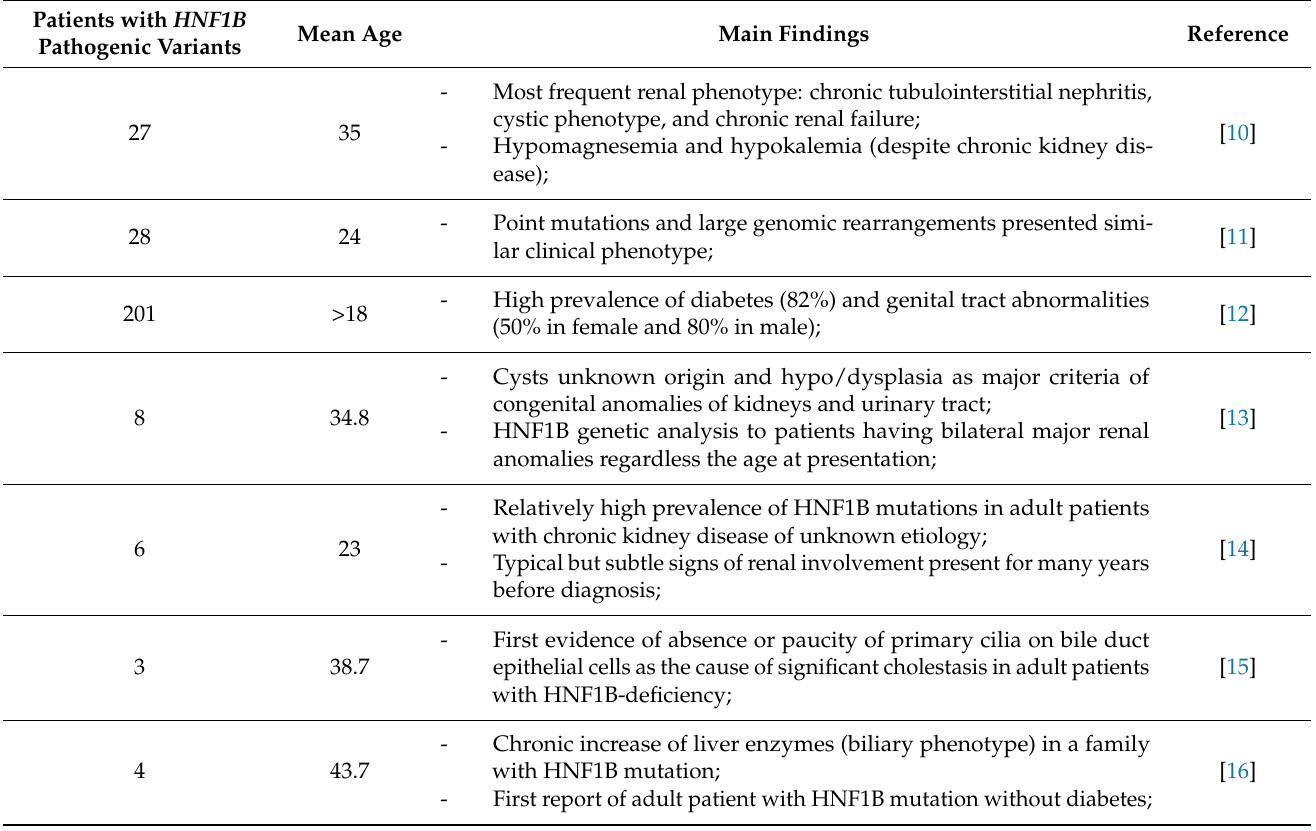
Table 1. List of the main studies evaluating the clinical manifestations of HNF1B mutations in the adult